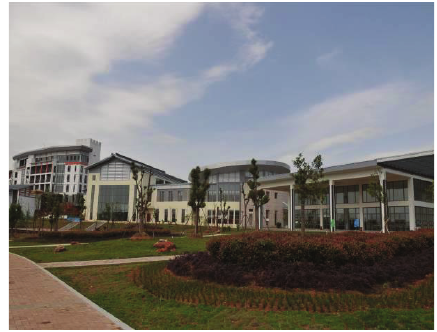
Figure 9: The LED lights used for landscape lighting before the visitor centre in Lushan West Sea highway rest area.